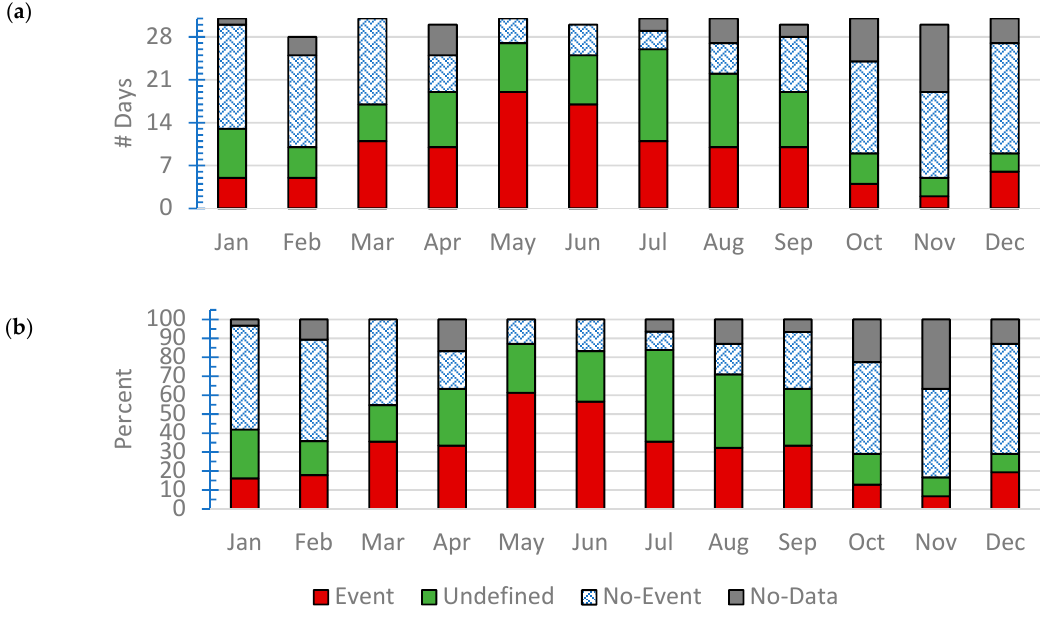
Figure 3. Occurrence of new particle formation events, non-event, undefined, and bad/missing data (i.e., no-data): ( a ) frequency and ( b ) monthly percentage.